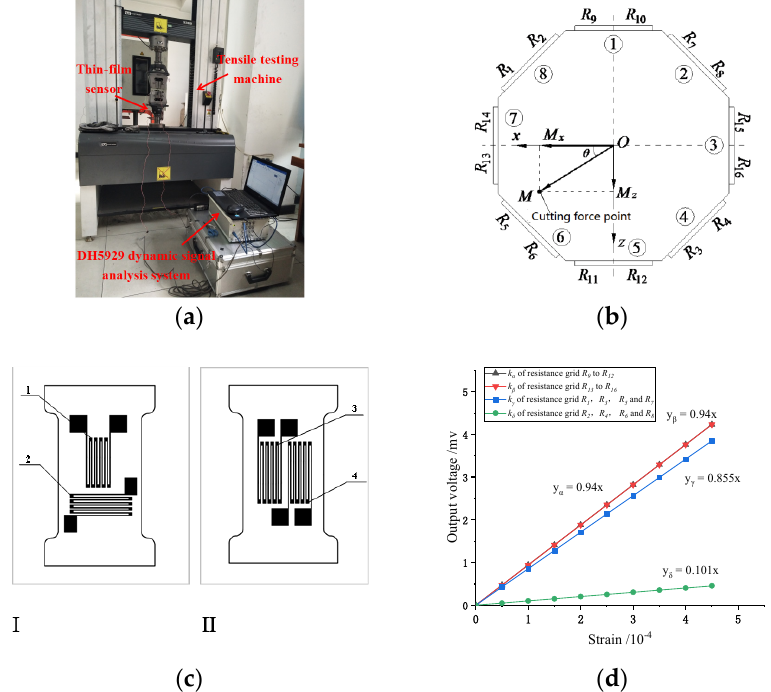
Figure 10. Tensile test of thin film strain sensor. ( a ) stretching device; ( b ) Distribution diagram of resistance grid; ( c ) Resistor grids I and II; ( d ) Output voltage and strain diagram of thin-film sensor.